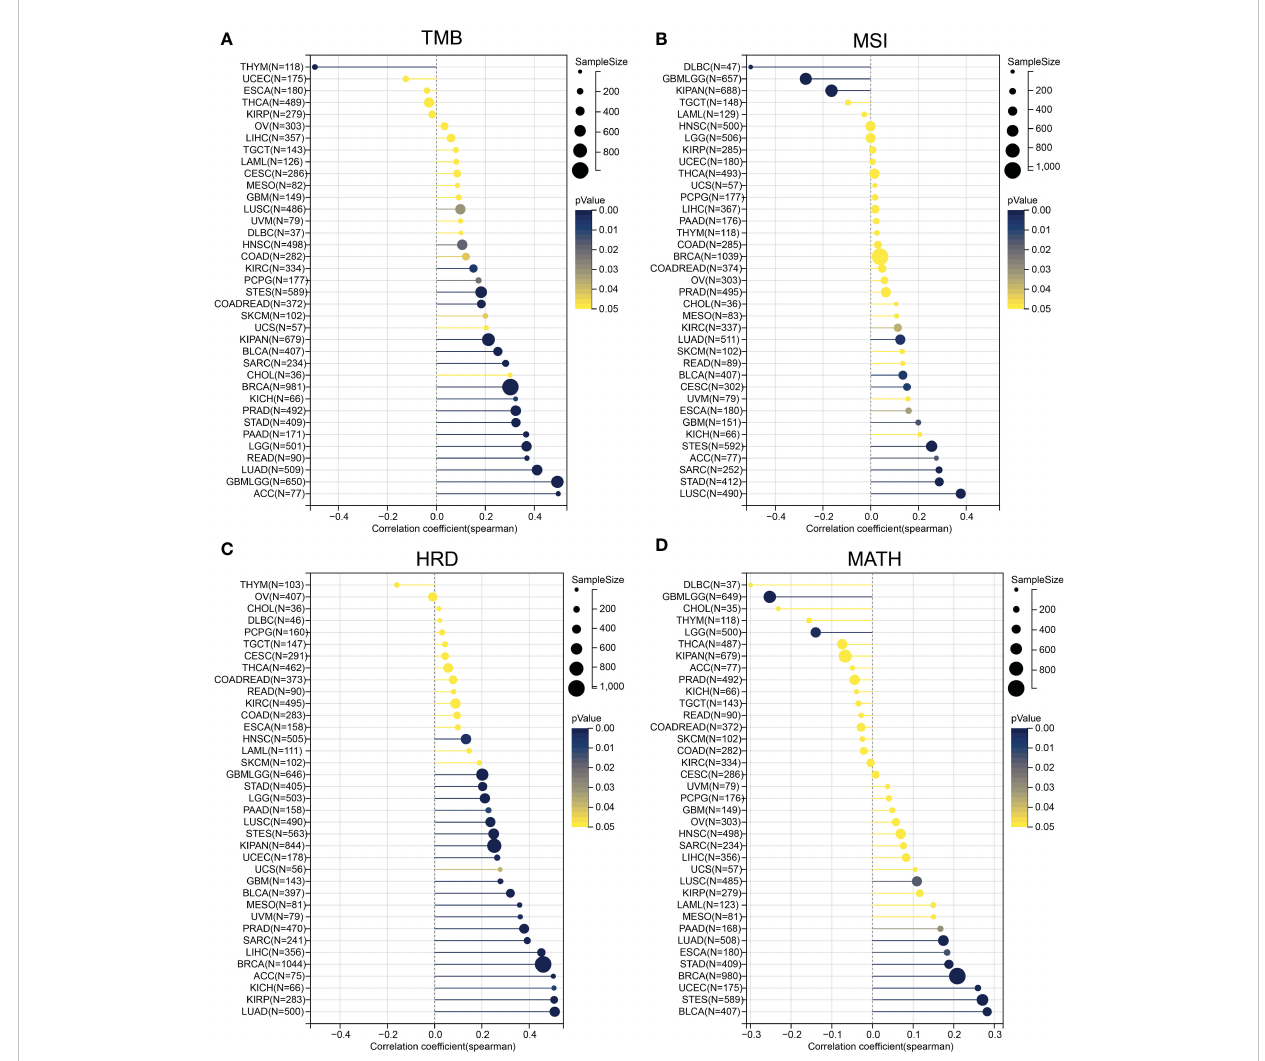
FIGURE 6 Correlation of ESPL1 with tumor heterogeneity. Correlation between ESPL1 expression and (A) TMB, (B) MSI, (C) HRD and (D) MATH. TMB, tumor mutational burden; MSI, microsatellite instability; HRD, homologous recombination de fi ciency; MATH, mutant-allele tumor